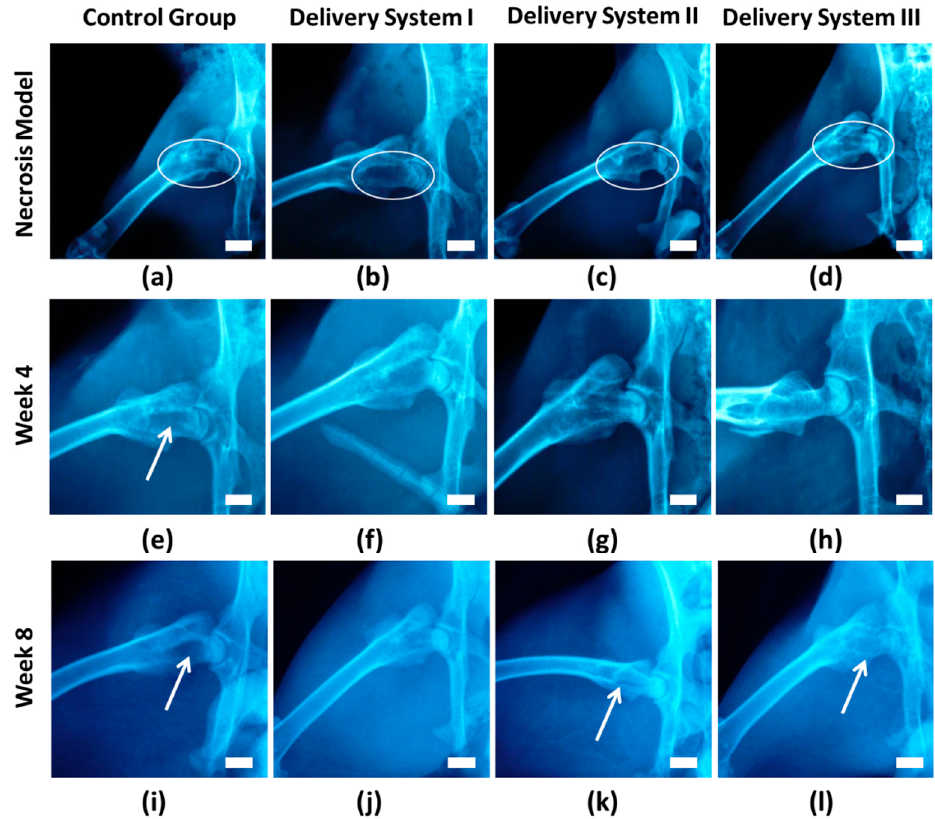
Figure 3. The X-ray images of the rabbit femur head in the right-posterior position at 4th and 8th weeks post-operation. The femoral head necrosis models were constructed by using the bone injection of anhydrous alcohol method ( a – d ), the circles indicated the necrosis district. Non-intervention treatment as a control group, images ( e , i ) showed femur head without treatment (control group) at 4th and 8th weeks respectively; images ( f , j ) showed femur head treated by composite hydrogel with delivery system I at 4th and 8th weeks respectively; images ( g , k ) showed femur head treated by composite hydrogel with delivery system II at 4th and 8th weeks respectively; images ( h , l ) showed femur head treated by composite hydrogel with delivery system III at 4th and 8th weeks, respectively. Scale bar: 1 cm, the arrows indicated the regeneration district.